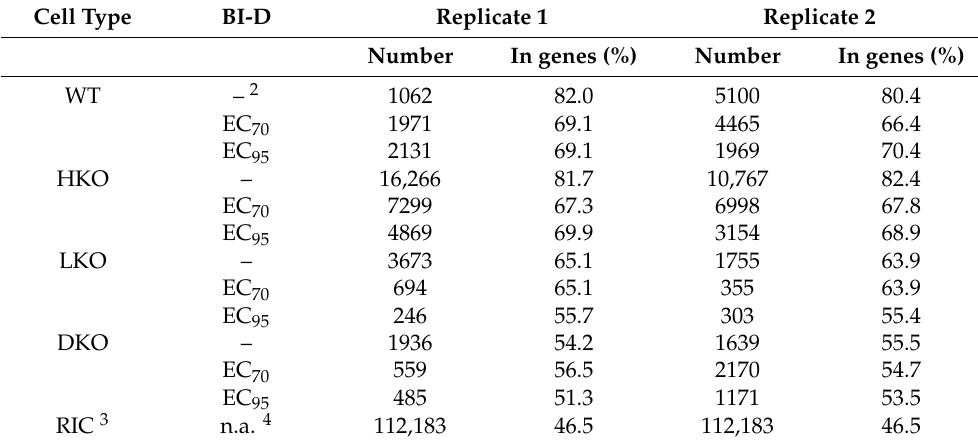
Table 1. Integration sites in BI-D-treated HEK239T cells 1